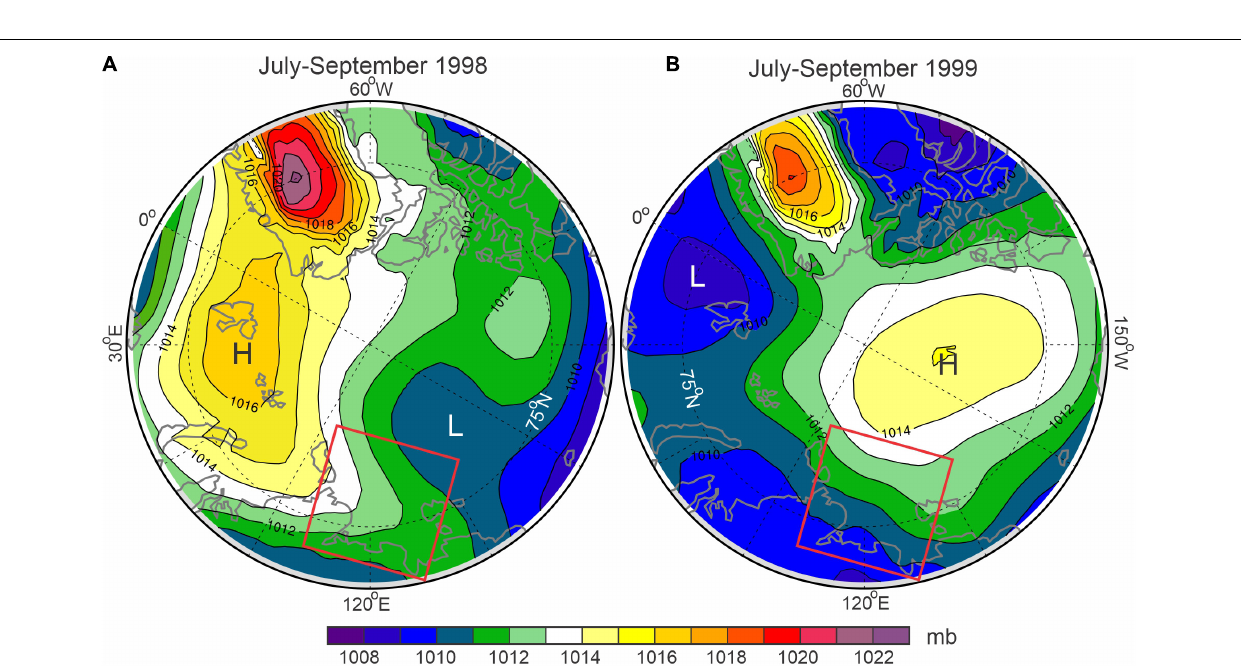
FIGURE 3 | Sea-level atmospheric pressure (mb) derived from ERA5 reanalysis for July–September (A) 1998 and (B) 1999. The red rectangle encloses the Laptev Sea. The black dashed lines depict meridians and parallels.